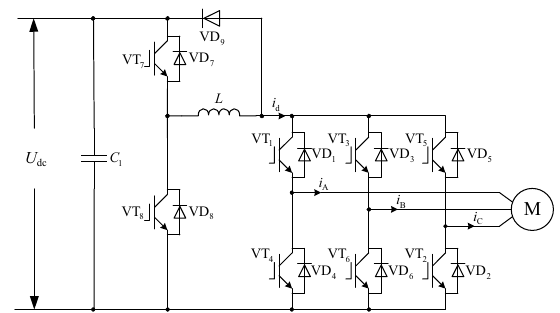
Figure 37 Current-source chopper